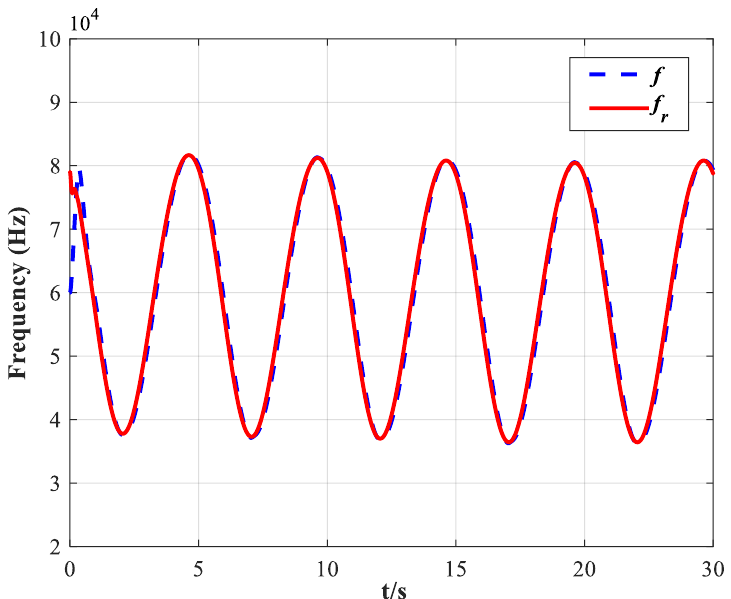
Figure 9. Tracking performance of the designed FT-NITSM resonant frequency tracking controller on its natural resonant frequency f r .